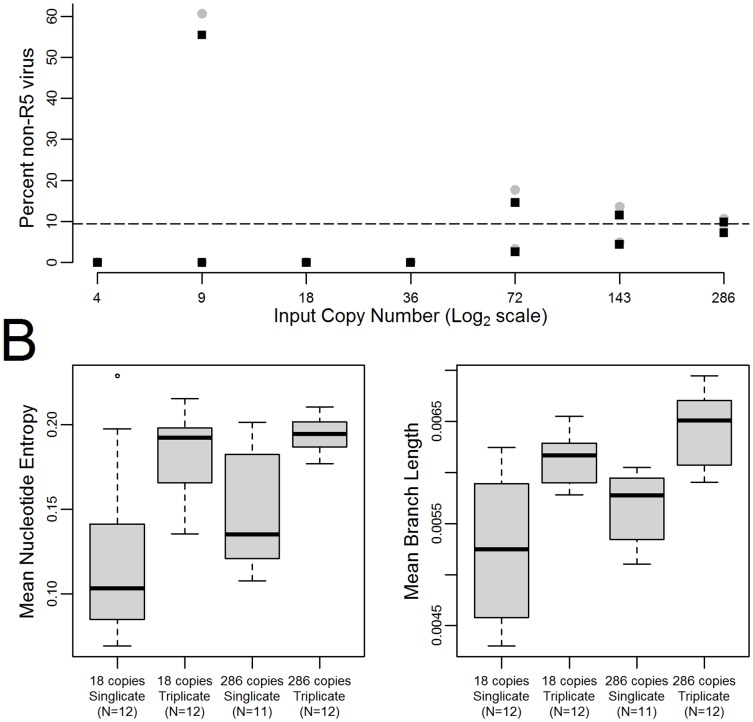
Sequence differences by viral load and PCR replication.A) Percent non-R5 virus detected at varying input copy numbers for a non-homogeneous clinical sample. The dashed line represents the approximate true value for percent of non-R5 virus. B) Measures of viral diversity for 18 and 286 input copies on the non-homogeneous clinical sample amplified with a single PCR and with triplicate PCR. Nucleotide entropies are shown on the left, mean phylogenetic branch length is shown on the right. Estimates tended to be more accurate when the input copy numbers were higher.